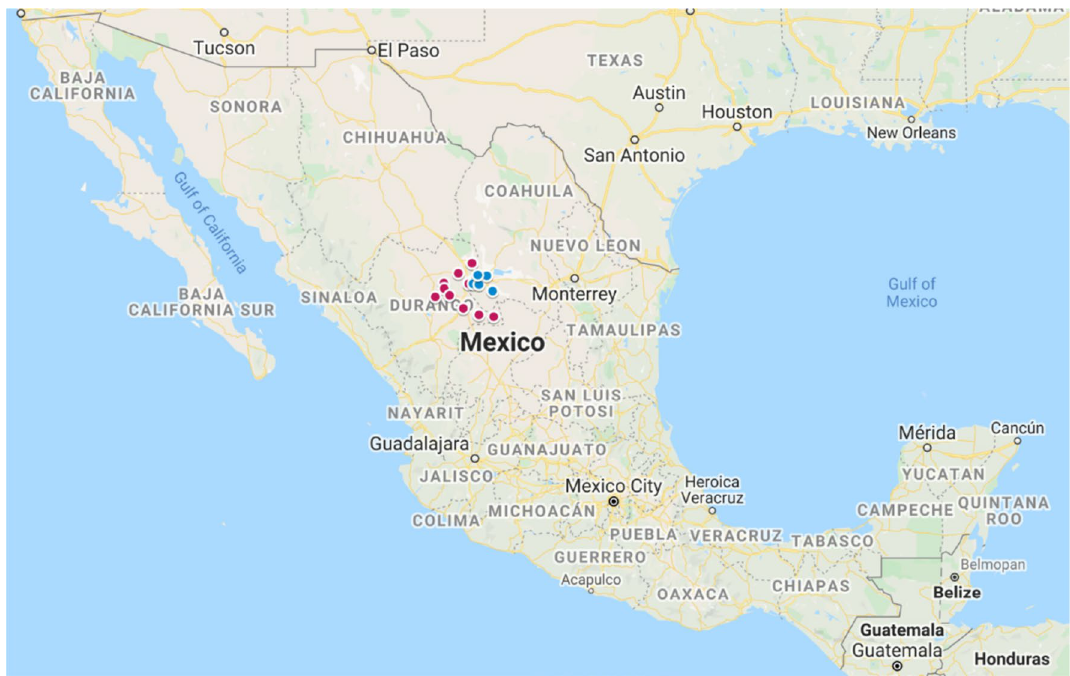
Figure 1. Map of Mexico indicating the Comarca Lagunera region from which the mastitis isolates were collected. The Comarca Lagunera region is marked with blue and pink dots. This region includes 5 municipalities of the Coahuila state (blue dots) and 11 municipalities of the Durango state (pink dots). The map was created from Google Maps (Map data Copyright 2020 Google) and edited in Microsoft PowerPoint